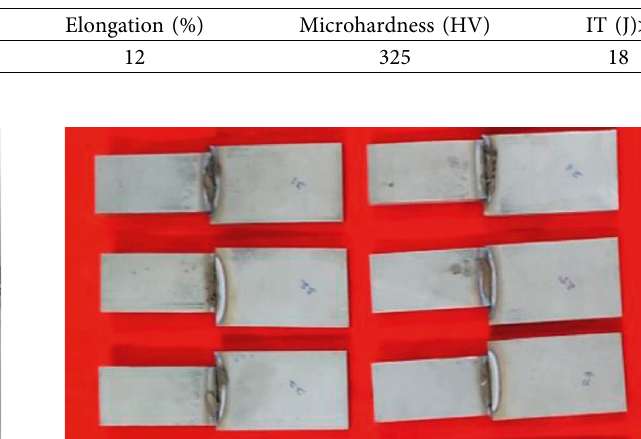
Table 2: Mechanical properties of Ti6Al4V alloy.